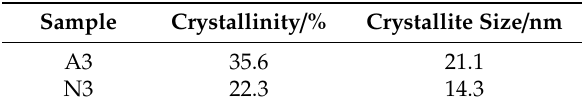
Table 1. Crystallinity and crystallite size of SiC nanowires grown on the substrate surface in the presence of Ni or Al 2 O 3 as catalysts.